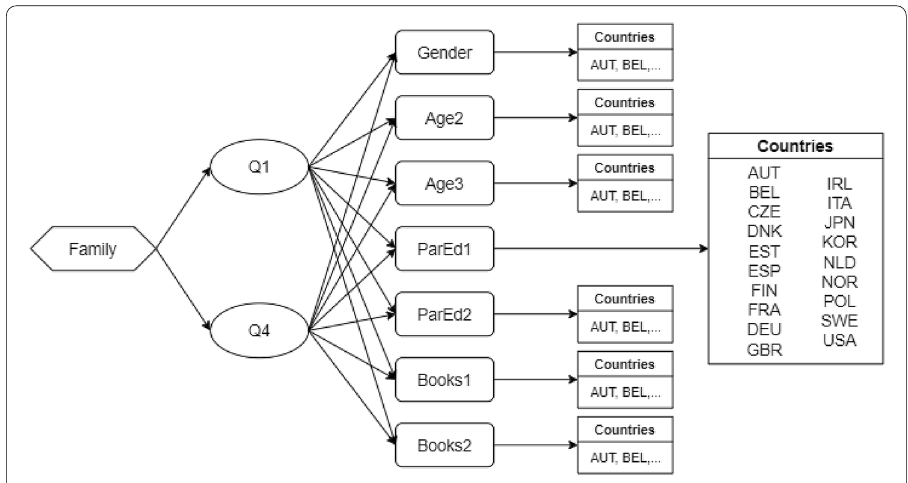
Fig. 1 The hierarchical structure of the hypotheses